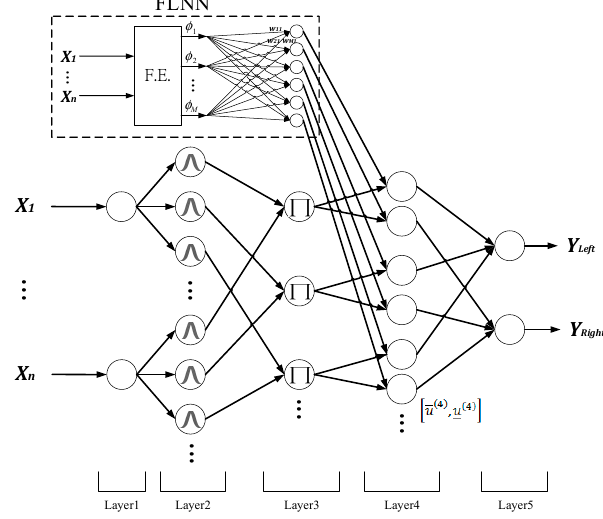
Figure 2. Structure of an interval type-2 fuzzy neural controller (IT2FNC).